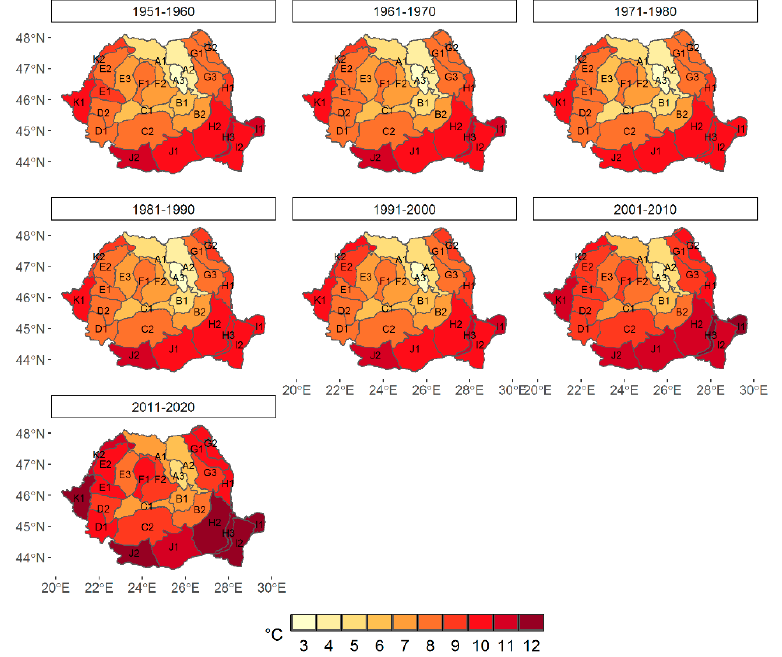
Figure 2. The variation of mean annual temperature by decade for the provenance subregions.